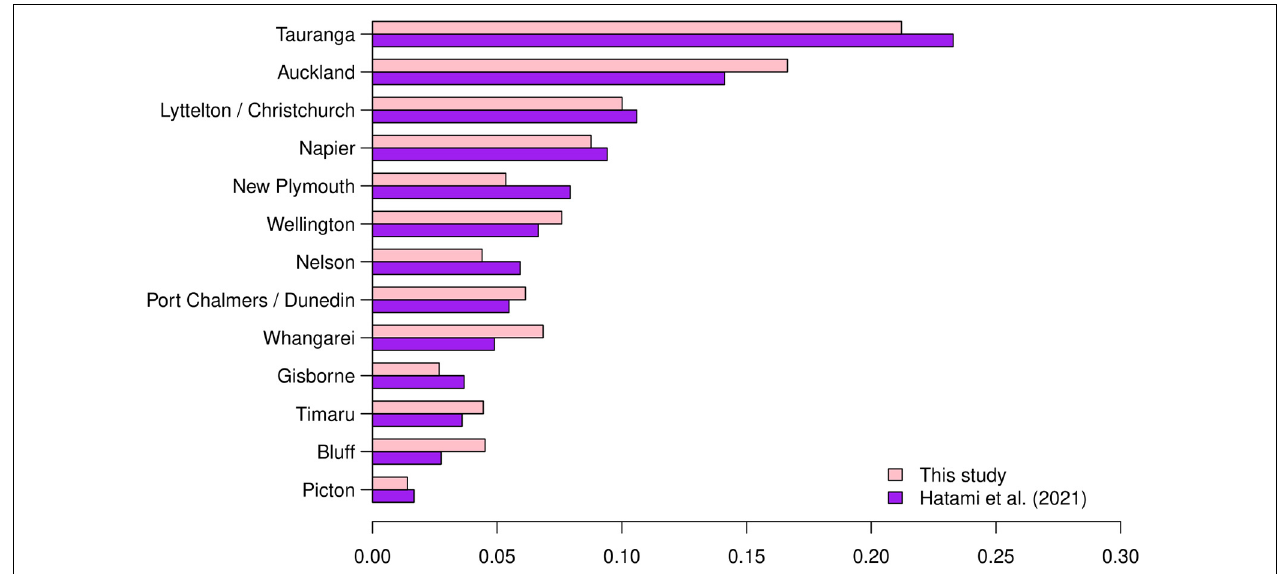
FIGURE 5 | A comparison of port allocation weights for New Zealand ports, as derived from our framework and from Hatami et al.